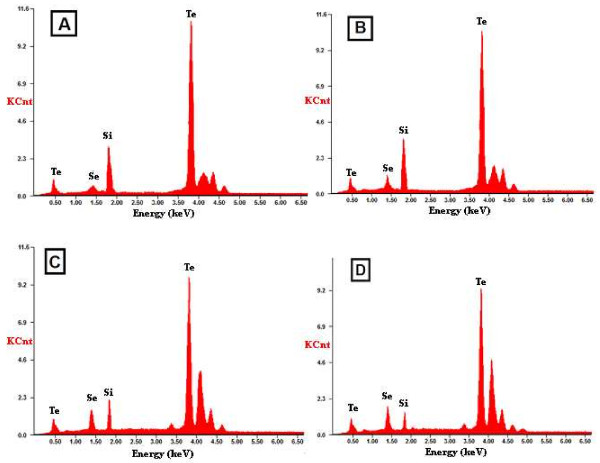
Typical EDS results for the thin films of nanoparticles. (A) Se3Te97, (B) Se6Te94, (C) Se9Te91, and (D) Se12Te88 nanoparticles.